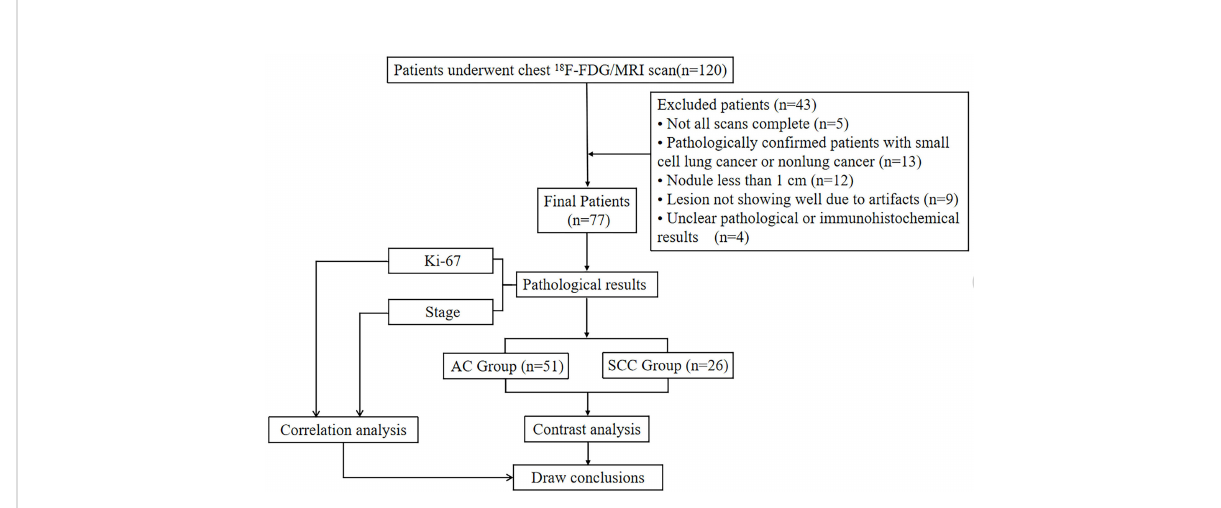
FIGURE 1 Flow diagram of the patient selection